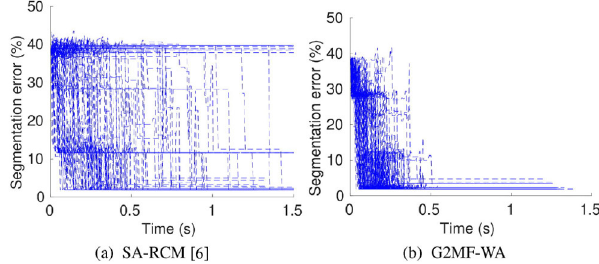
Fig. 4 Convergence analysis on the dataset Hartley from Ref. [28]. Dotted lines denote convergence curves for different random